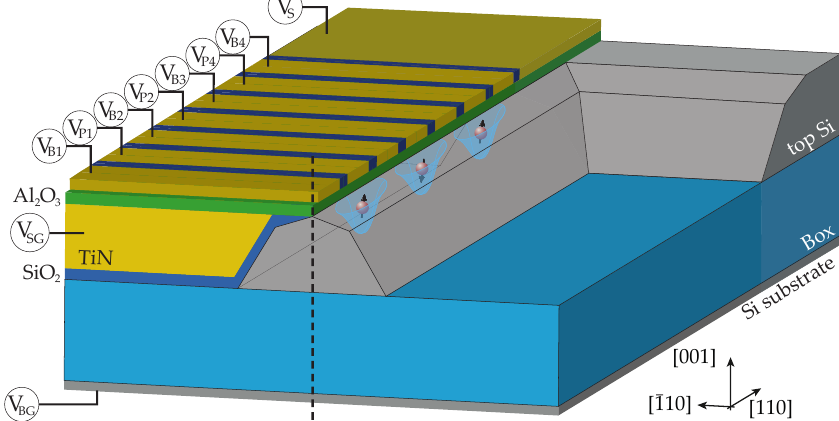
Figure 1. Schematic of the envisioned qubit device showing the silicon nano-ridge and the TiN gate array for electron spin localization. The trapezoidal silicon nano-ridge is fabricated on a fully-depleted silicon-on-insulator (FDSOI) substrate, providing a global back-gate set on voltage V BG underneath the buried oxide (Box). Buried TiN side-gates are used to tune the confinement of the electron wave function along the [¯110] crystal axis. TiN gates, perpendicular to the silicon nano-ridge, tune the chemical potential within each quantum dot by applying a voltage V P,n and the potential barrier between adjacent quantum dots by applying a voltage V B,n . Two electronic reservoirs, each tunnel-coupled to one end of the nano-ridge, are induced by applying a positive voltage to large top-gates covering the area adjacent to the ends of the nano-ridge (here, V S for the source reservoir is shown). The dashed line indicates a symmetry axis with respect to the gate structure. Note that the side-gate and top-gate pattern on the right-hand side of the device, as well as the drain reservoir at the front end of the nano-ridge are not